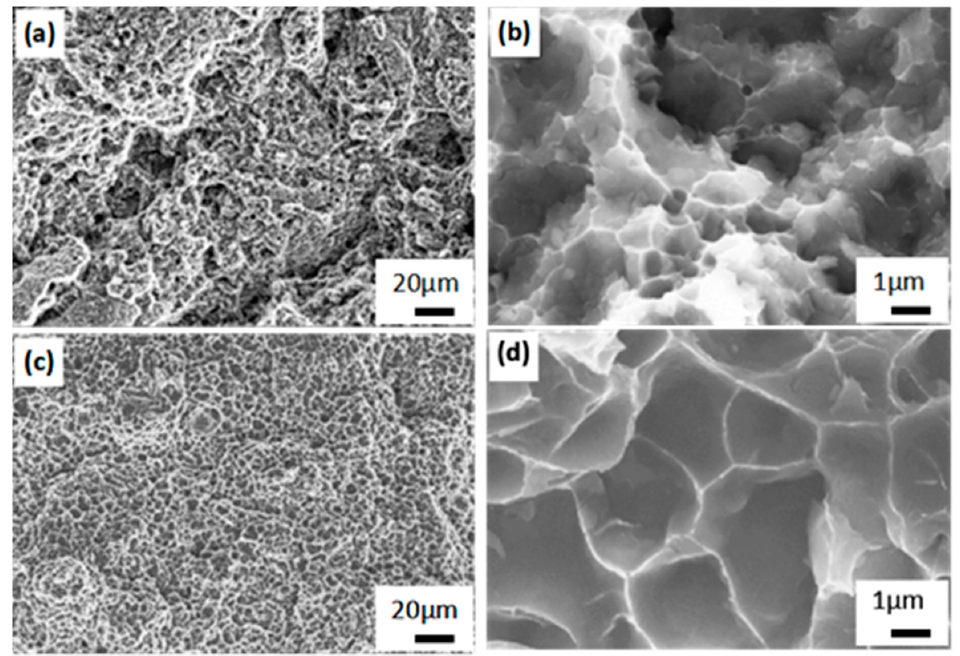
Figure 9. Fracture surface of tensile samples: ( a,b ) as-prepared SLM, ( c,d ) SLM and heat treated at 673 K for 6 h.